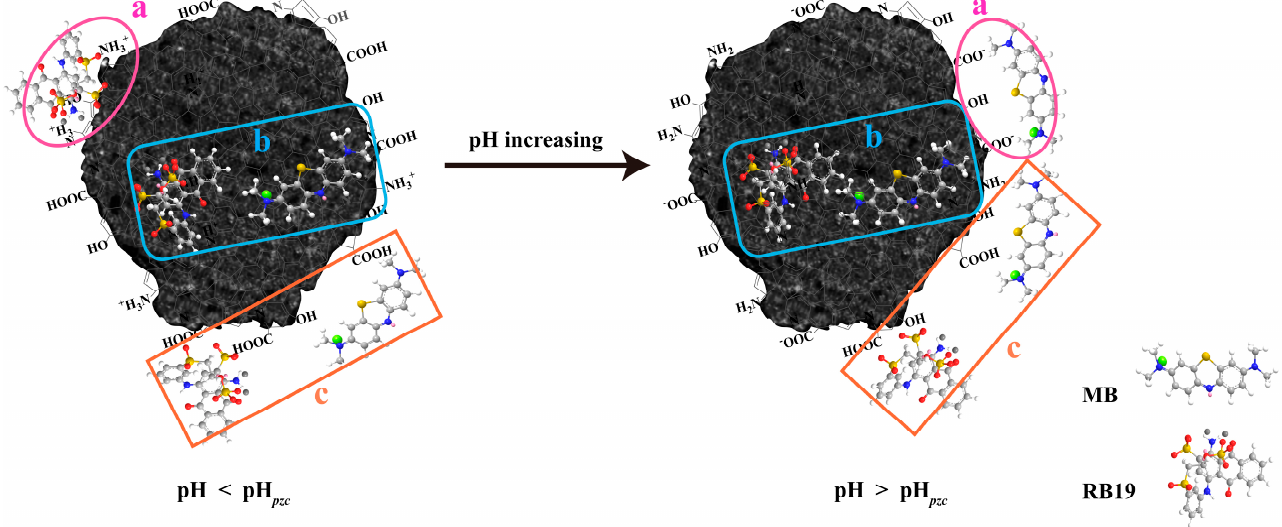
Figure 6. Possible adsorption mechanism of MB and RB19 onto N-CM in natural aqueous solution: ( a ) Electrostatic attraction, ( b ) π - π stacking, and ( c ) hydrogen bonding.